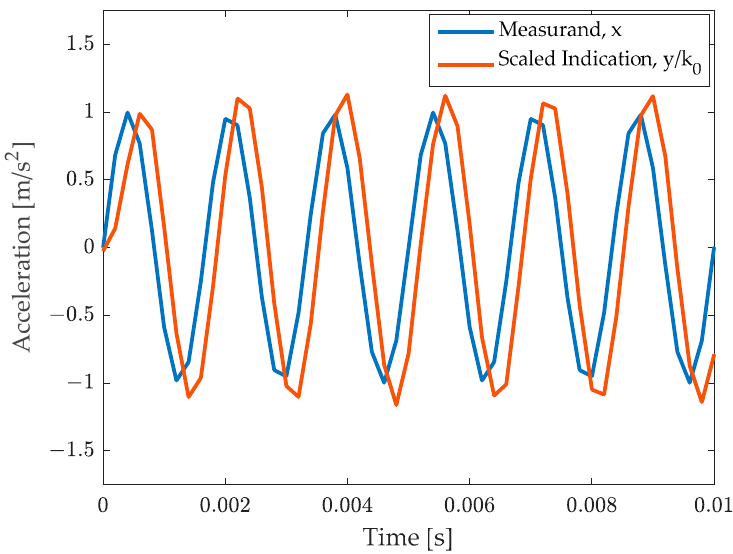
Figure 2. Comparison of the measurand with the (uncompensated) scaled instrument indication.